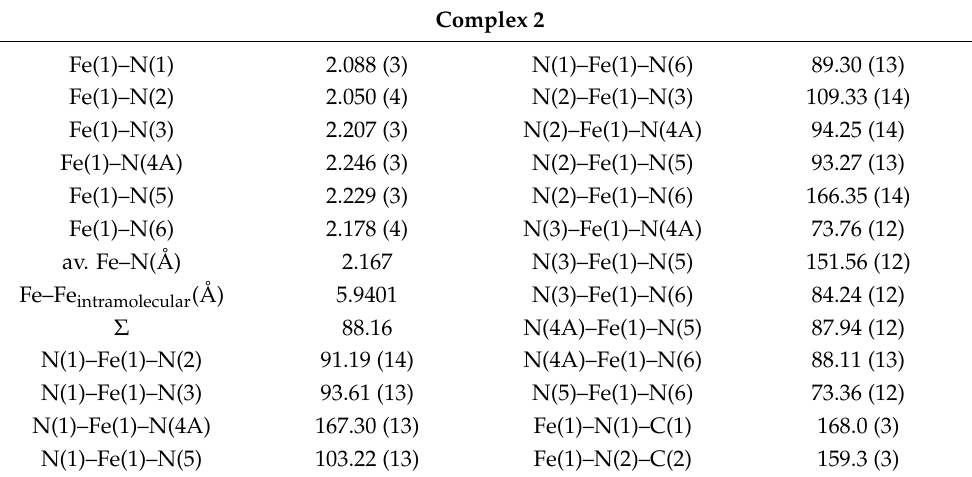
Table 2. Selected bond lengths [Å] and angles [ ◦ ] in the structure of complex 2 at 100